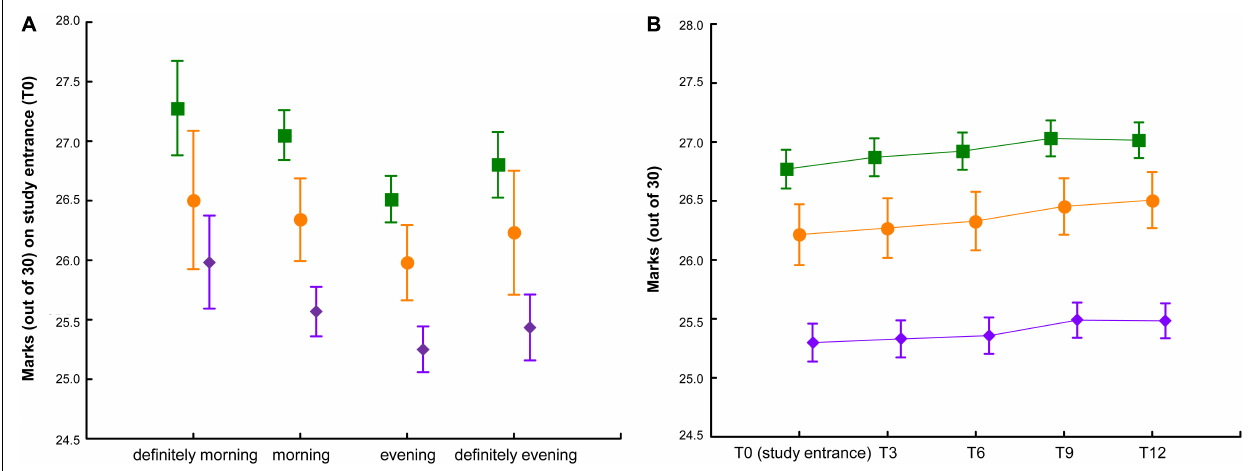
FIGURE 4 | Average marks by study subject, chronotype, and over time. (A) Average marks (out of 30) by study subject [science and technology (S): purple diamonds; health and medical (M): orange circles; social and humanities (H): green squares] and by chronotype (definitely morning n = 349, morning n = 1,193, evening n = 1,390, definitely evening n = 647) [ F ( 3 , 3 , 577 ) = 8.7, p chronotype < 0.0001, F ( 2 , 3 , 577 ) = 90.0, p study subject < 0.0001; F ( 6 , 3 , 577 ) = 0.3, p interaction n.s.] on study entrance (T0). (B) Average marks (out of 30) by study subject [science and technology (S, n = 858): purple diamonds; health and medical (M, n = 332): orange circles; social and humanities (H, n = 820): green squares] over time, aligned based on the date of joining the initiative [ F ( 4 , 8 , 028 ) = 123.5, p time < 0.0001, F ( 2 , 2 , 007 ) = 96.3, p study subject < 0.0001; F ( 8 , 8 , 028 ) = 2.8, p interaction < 0.0001]. Values are expressed as means ± 95% confidence intervals. n.s., not statistically significant.